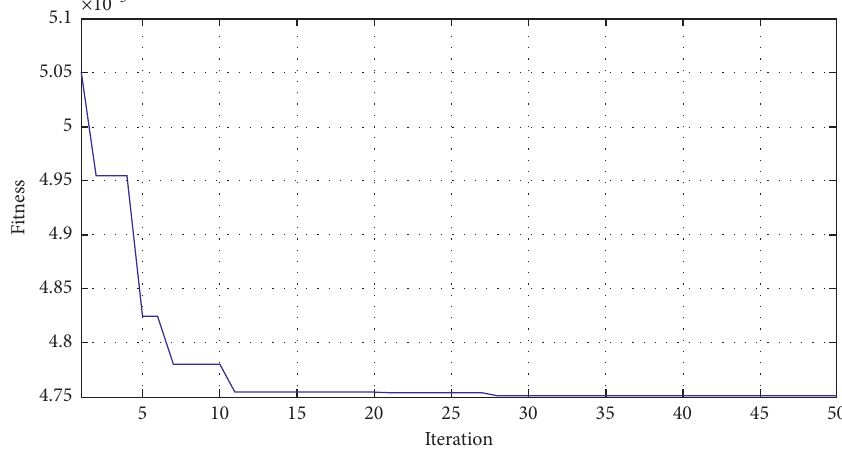
Figure 11: ABC-SVR optimal value convergence